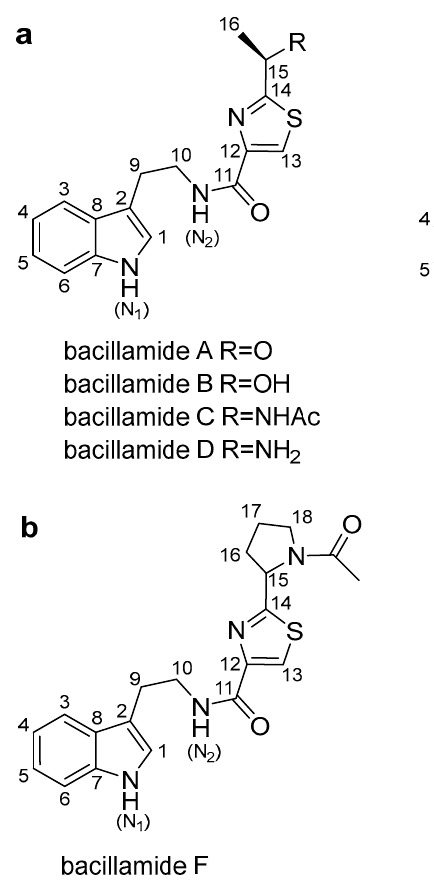
Figure 1. The bacillamide family structures of compounds: ( a ) This represents the known bacil- lamide compounds (bacillamide A–E); ( b ) This represents the new compound, bacillamide